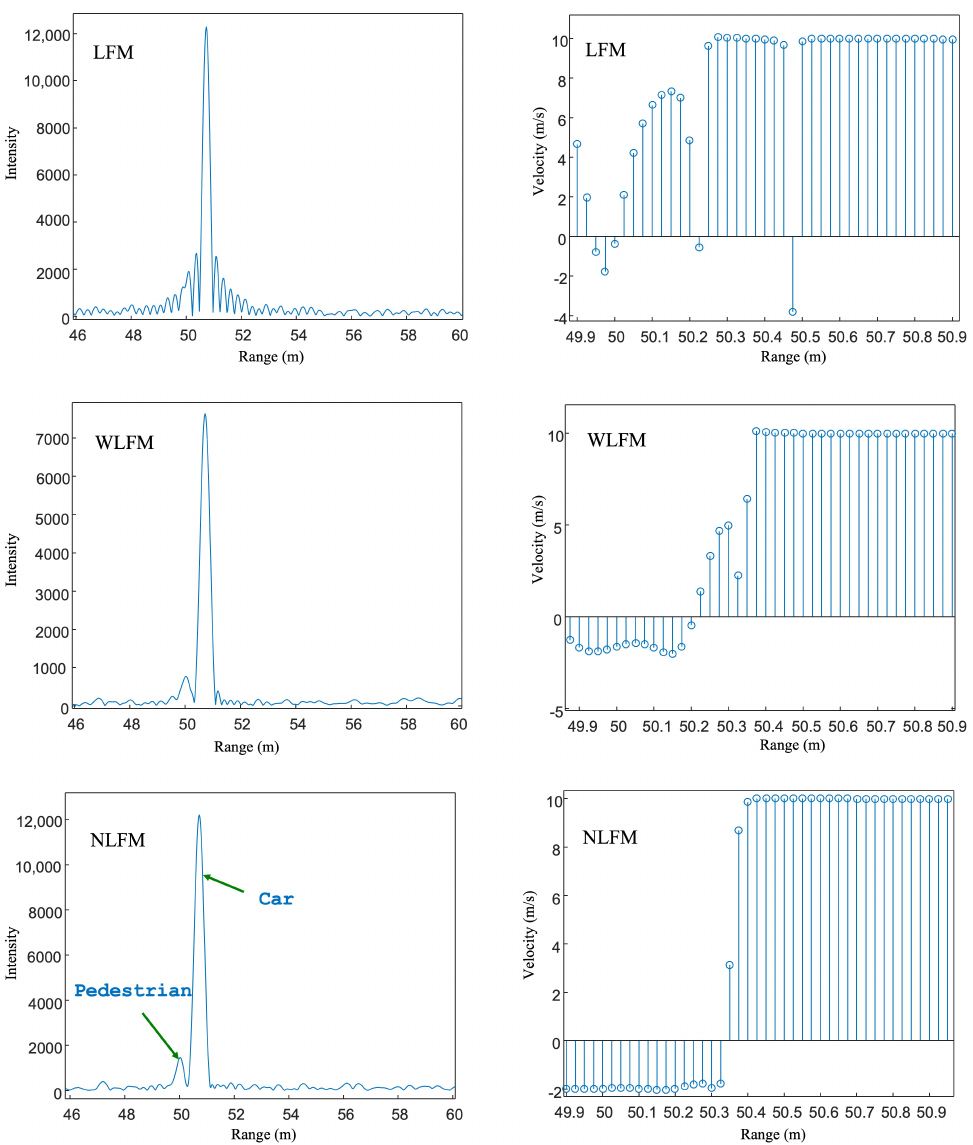
Figure 8. Range detection and velocity measurements for the targets at SNR of 0